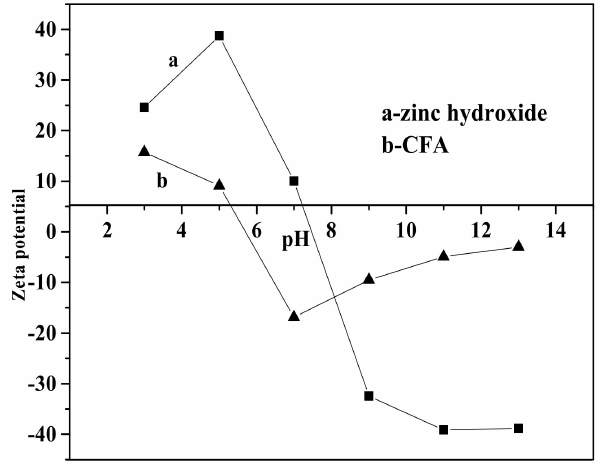
Figure 9. Zeta potential of zinc hydroxide and calcined fly ash (CFA) at di ff erent pH